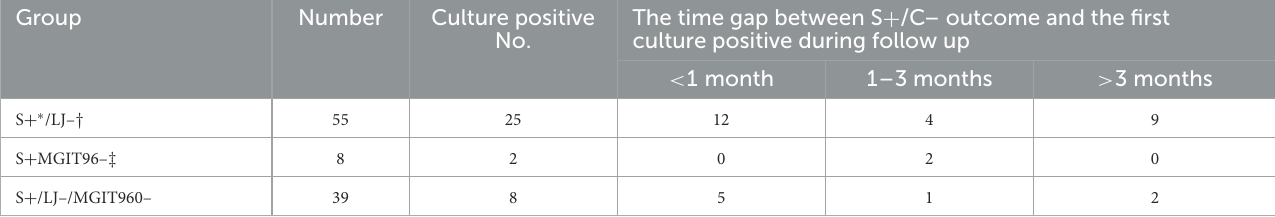
TABLE 1 The outcomes of the 102 patients with follow-up culture after the S + /C– evaluation enrollment. Group Number Culture positive The time gap between S + /C– outcome and the first No. culture positive during follow up < 1 month 1–3 months > 3 months